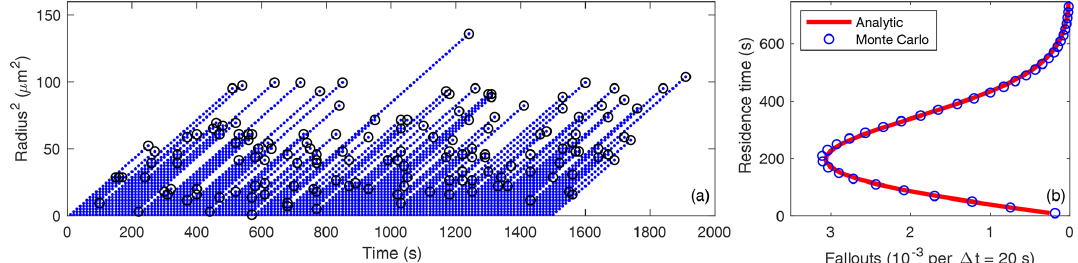
Figure 2. (a) Same as the Fig. 1a except that the droplet fallout times are indicated by black circles. (b) Frequency distributions of the droplet residence time from the Monte Carlo model (for 1 . 5 × 10 6 droplets) and from the analytic solution (Eq. 56) for the same